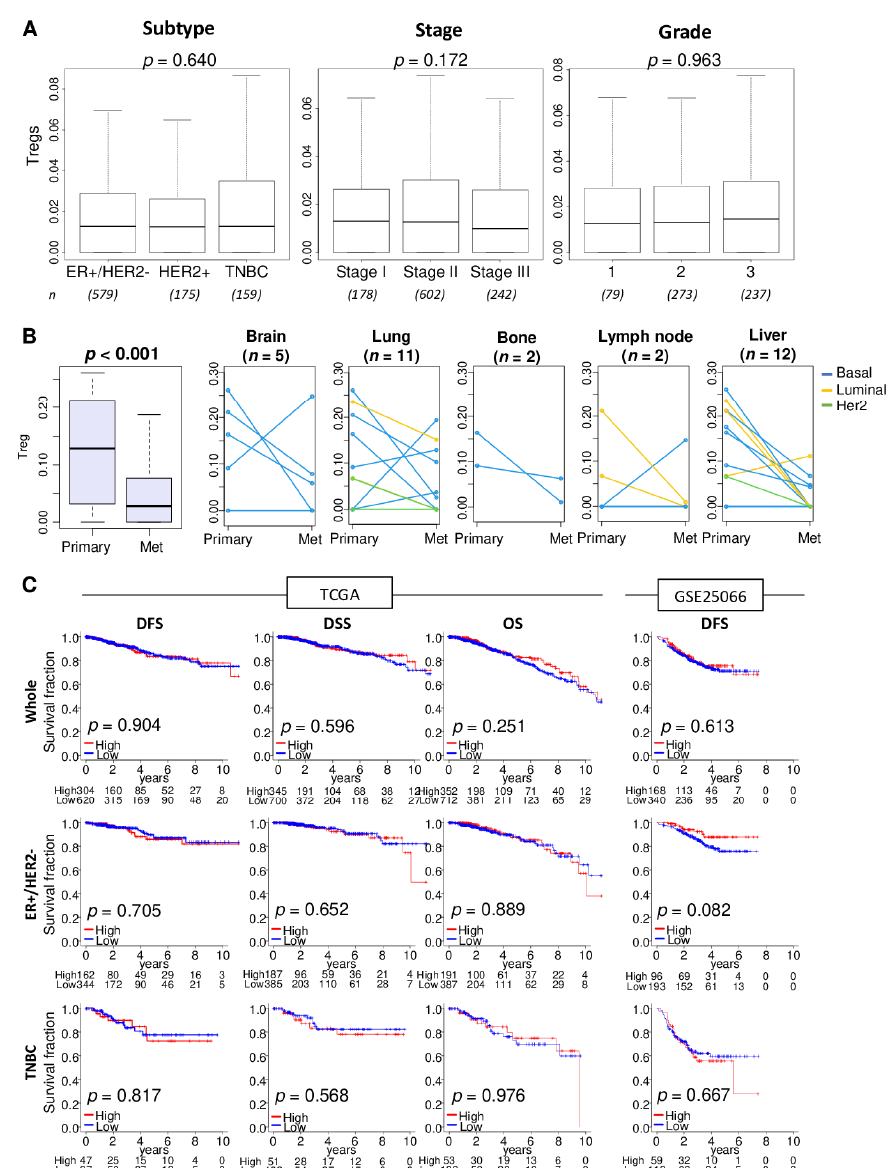
Figure 1. Association of Tregs abundance with clinical characteristics, metastasis, and survival outcomes. ( A ) Boxplots of Tregs level distribution by subtype, American Joint Committee on Cancer stages, and Nottingham pathological grade in the TCGA cohort. Kruskal-Wallis test was used for the analysis. Group sizes are shown underneath the plots. ( B ) Boxplots of the Tregs levels in the primary breast cancer and different metastatic tumors. Matched pair comparison of Treg levels between the primary and each metastatic tumor; brain, lung, bone, lymph node, and liver in the GSE110590 cohort. Mann - Whitney U test was used to the analysis. Blue line; Basal type, yellow line; Luminal type, and green line; Her2 type. ( C ) Disease-free survival (DFS), disease-specific survival (DSS), and overall survival (OS) stratified by Tregs levels (low (blue line) and high (red line)) within whole tumors, estrogen receptor (ER)-positive / human epidermal growth factor receptor 2(HER2)-negative, and triple negative breast cancer (TNBC) in the TCGA and GSE25066 cohorts. The top tertile percent was used as a cut-o ff between high and low Tregs groups within each cohort. Log-rank test with Kaplan-Meier survival curves was used for the survival